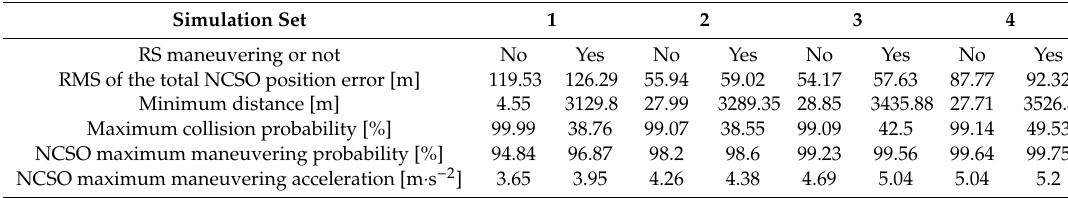
Table 2. Summary of results from the proposed algorithms.